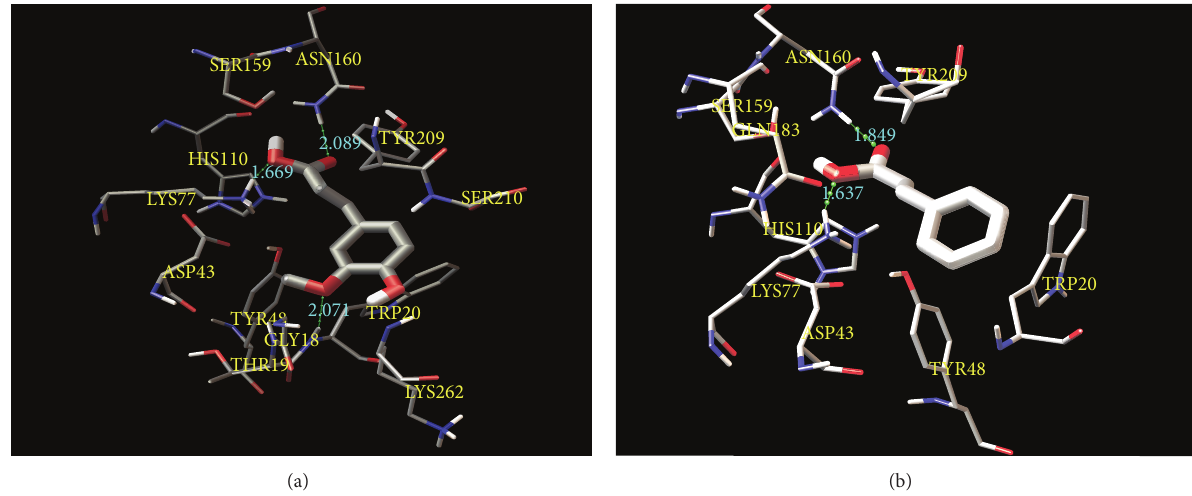
Figure 3: Interaction analysis of cinnamic acid derivatives docked with ALR2. Binding pose of ferulic acid (a) and transcinnamic acid (b). The amino acid residues (in 1 ˚ A distance) were represented in atom types and the hydrogen bonds were denoted in green spheres along with the distance.